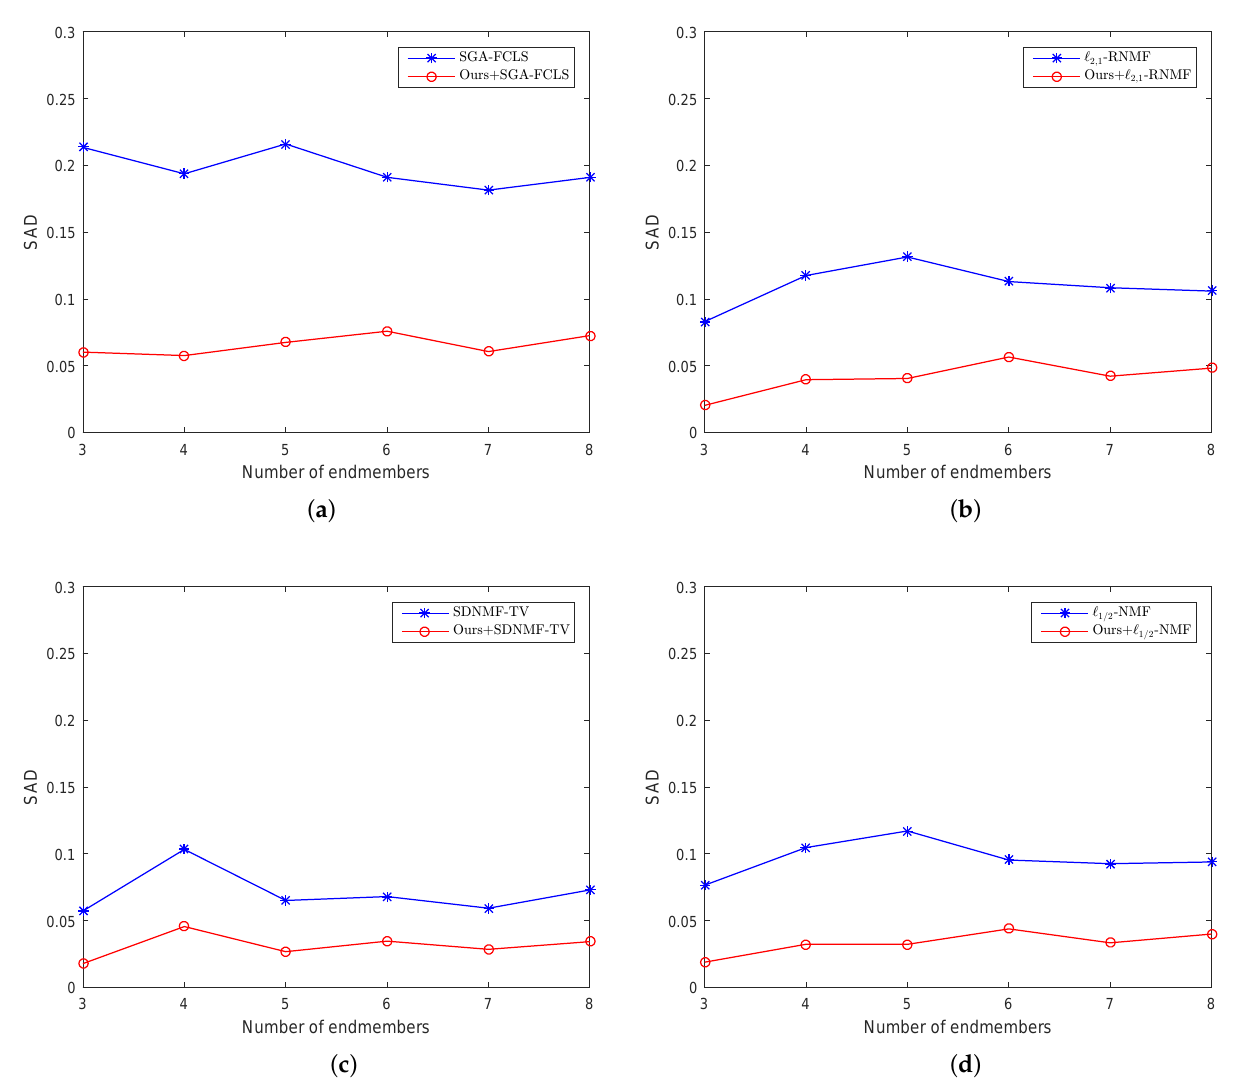
Figure 9. The SAD results of unmixing algorithms with/without our proposed method when applied to data of different numbers of endmembers. ( a ) SGA-FCLS. ( b ) (cid:96) 2,1 -RNMF. ( c ) SDNMF-TV. ( d ) (cid:96) 1/2